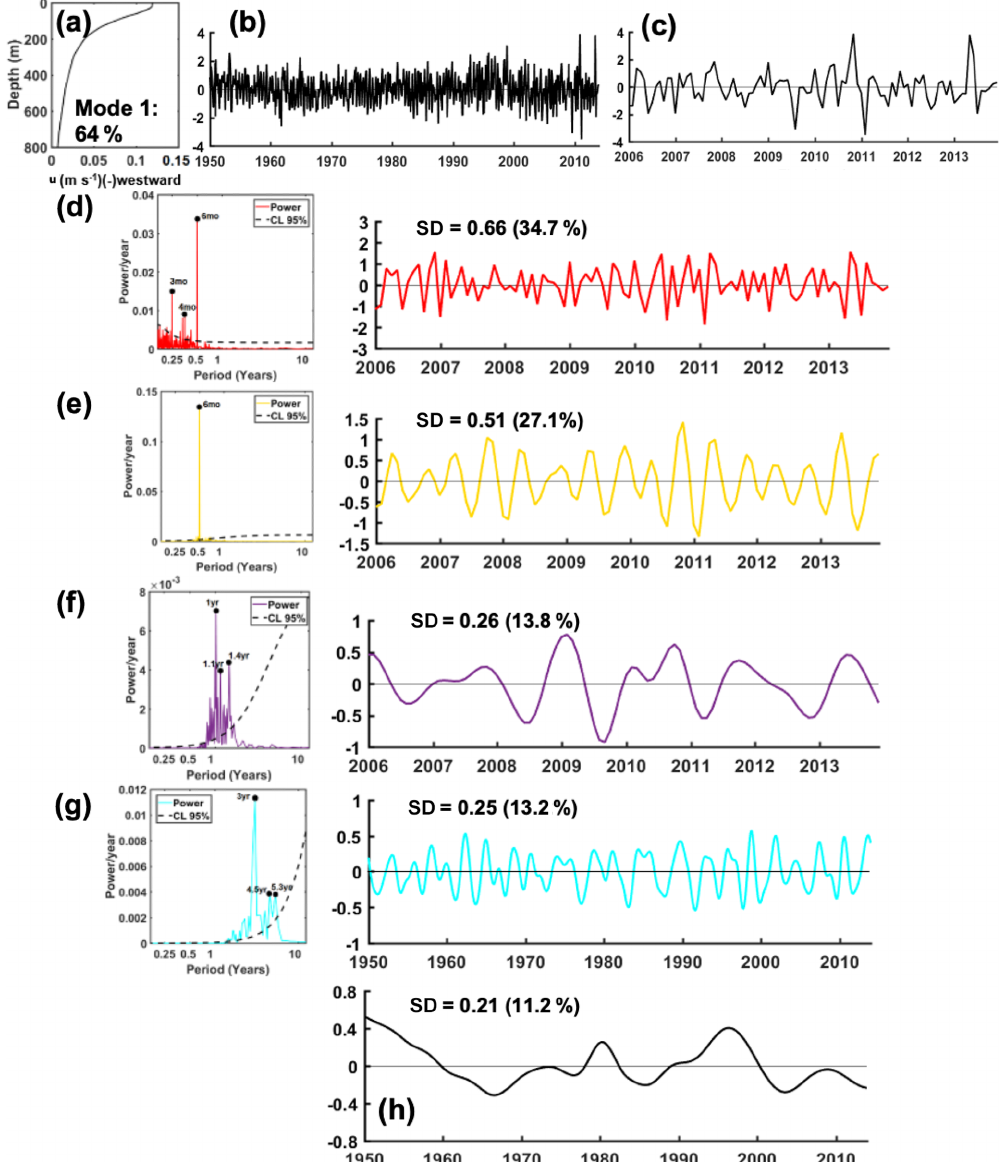
Figure 11. The same as Fig. 10 but for point B SM , with the temporal variability of EOF1 accounting for 64% of total